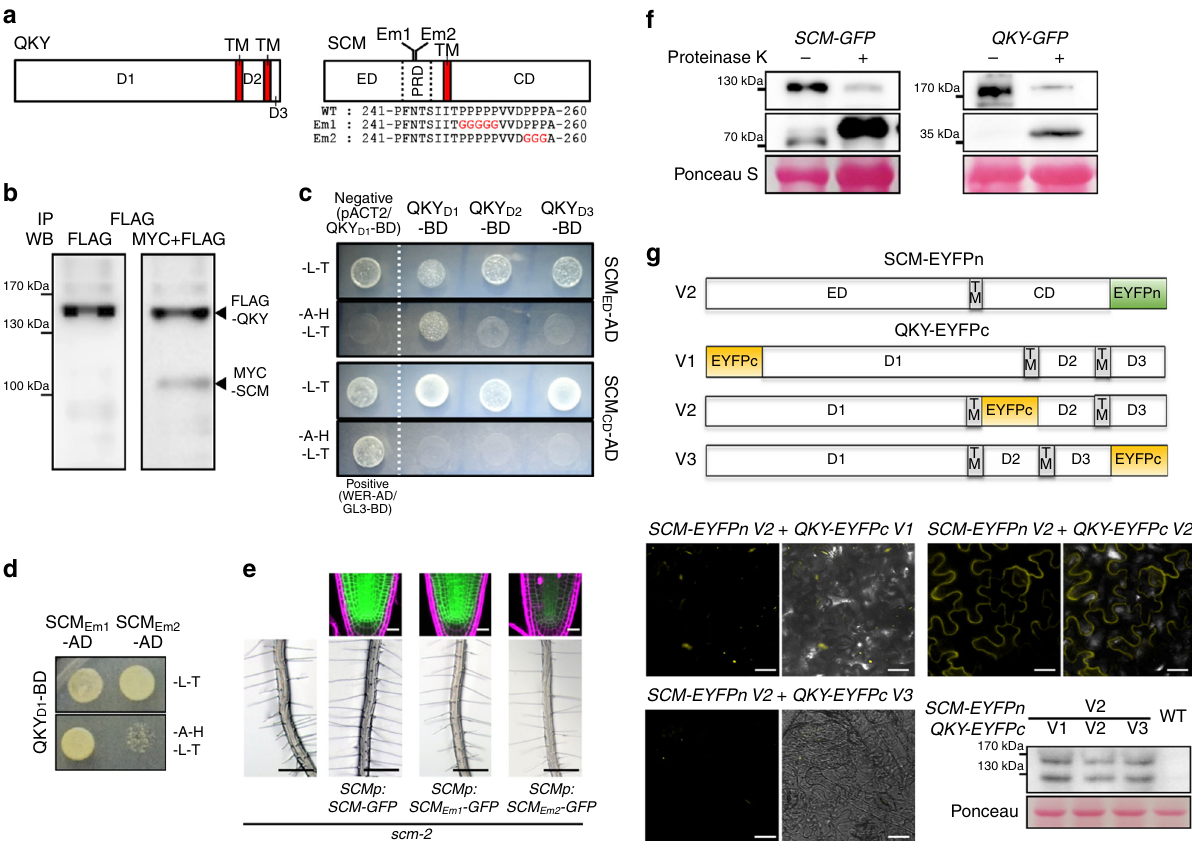
Fig. 4 Interaction between QKY and SCM proteins. a Structure of the QKY and the SCM proteins. Schematic representation of QKY (left) shows the N- terminus domain (D1) and the other two domains (D2 and D3) separated by two transmembrane domains (TM). Schematic representation of SCM (right) shows the extracellular domain (ED) containing a proline-rich domain (PRD), and the cytosolic domain (CD), which are separated by one transmembrane domain (TM). b Coimmunoprecipitation of QKY with SCM protein. The experiment was performed with total protein extracts from Nicotiana benthamiana leaves transiently transformed with SCM-MYC and QKY-FLAG. c Yeast two-hybrid assay with QKY and SCM. The construct combinations were cointroduced into the yeast strain AH109. Transformants were grown on the -L-T (lacking leucine and tryptophan) control plates and the -A-H-L-T (lacking adenosine, histidine, leucine and tryptophan,) selective plates for 3 days. The combination of WER/GL3 was used as a positive control, and pACT2(empty vector)/QKY-D1 as a negative control (BD: pAS2-1; AD: pACT2). d Effect of mutations in the SCM PRD on the interaction between QKY and SCM in a yeast two-hybrid assay. Mutations are shown in the right panel of ( a ). e Effect of mutations in the SCM PRD on the SCM-GFP protein level (top, bar = 20 μ m) and the root hair phenotype (bottom, bar = 250 μ m). f Proteinase K protection test. Protoplasts from SCMp:SCM-GFP and QKYp:QKY-GFP stable transgenic plants were treated with proteinase K (1 ng/ μ l). Total protein extracts were subjected to immunoblotting using monoclonal anti-GFP antibodies. g BiFC assay with QKY and SCM. SCM-EYFPn-V2 in which the N-terminal half of EYFP (EYFPn) was fused to the C-terminus of SCM and QKY-EYFPc-Vx in which the C-terminal half of EYFP (EYFPc) was fused to various sites as shown in the upper panel were coexpressed in the Nicotiana benthamiana leaf epidermal cell using a biolistic particle delivery system. Their expression was con fi rmed by western blot analysis with total protein extracts using polyclonal anti-GFP antibodies. The red and the black asterisks indicate the QKY-EYFPc protein and the SCM-EYFPn protein, respectively. Bar = 25 μ